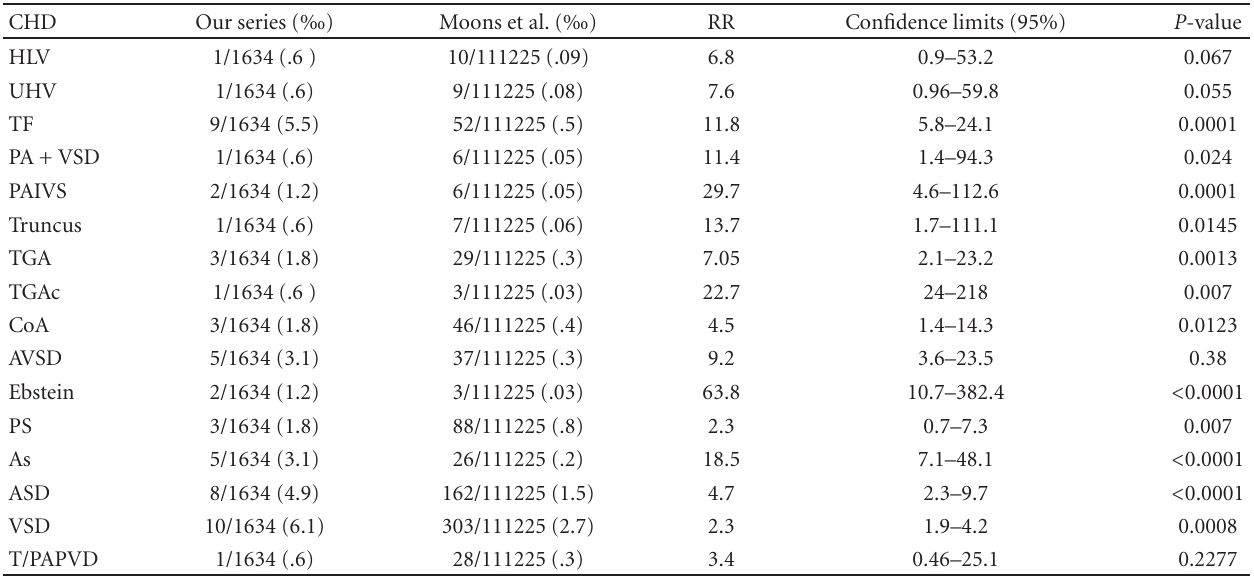
Table 3: Relative risks ratios—comparison between our series and normal population (Moons et al.). CHD Our series (‰) Moons et al. (‰) RR Confidence limits (95%) P